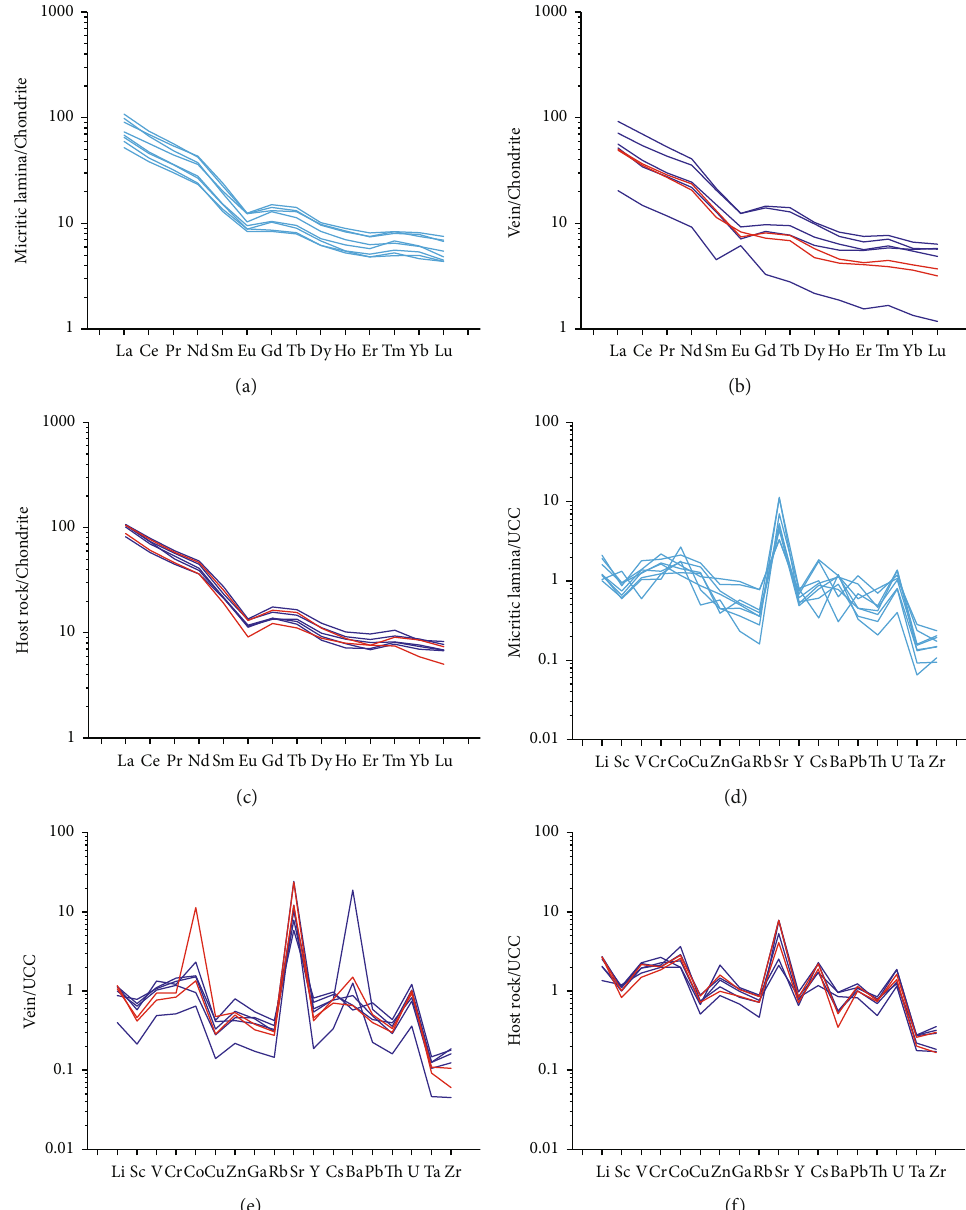
Figure 11: Spider diagram of the ratio of trace elements and the pattern of rare earth elements (REEs). Chondrite-normalized REE patterns in (a) micritic laminae, in (b) veins, and in (c) host rocks. Trace elements normalized by UCC in (a) micritic laminae, in (b) veins, and in (e) host rocks. Blue lines: fi brous calcite and its host rock; red lines: blocky veins and its host